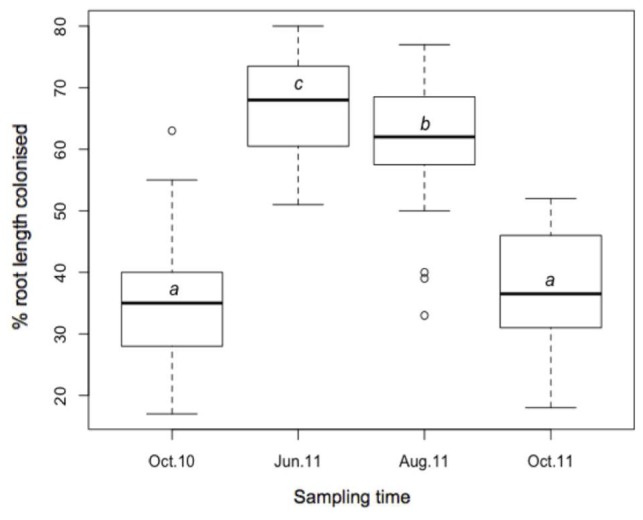
Boxplot of AMF root length colonization; October-10, June-11, August-2011, and October-11, where a, b, and c are significantly different means (t-test).